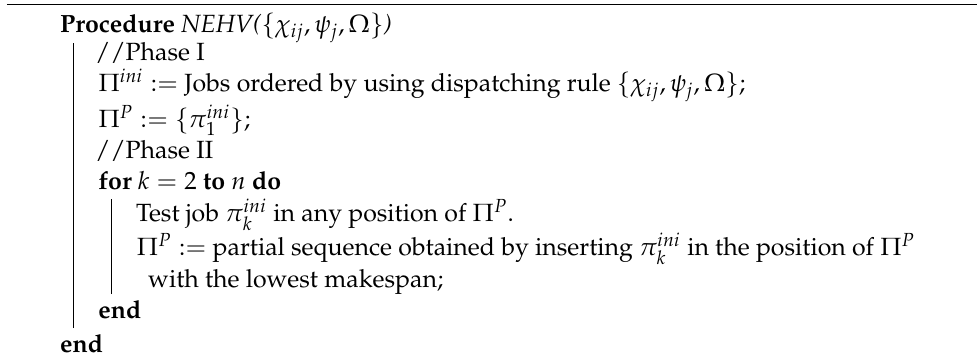
Algorithm 1: Pseudo-code of the proposed NEH